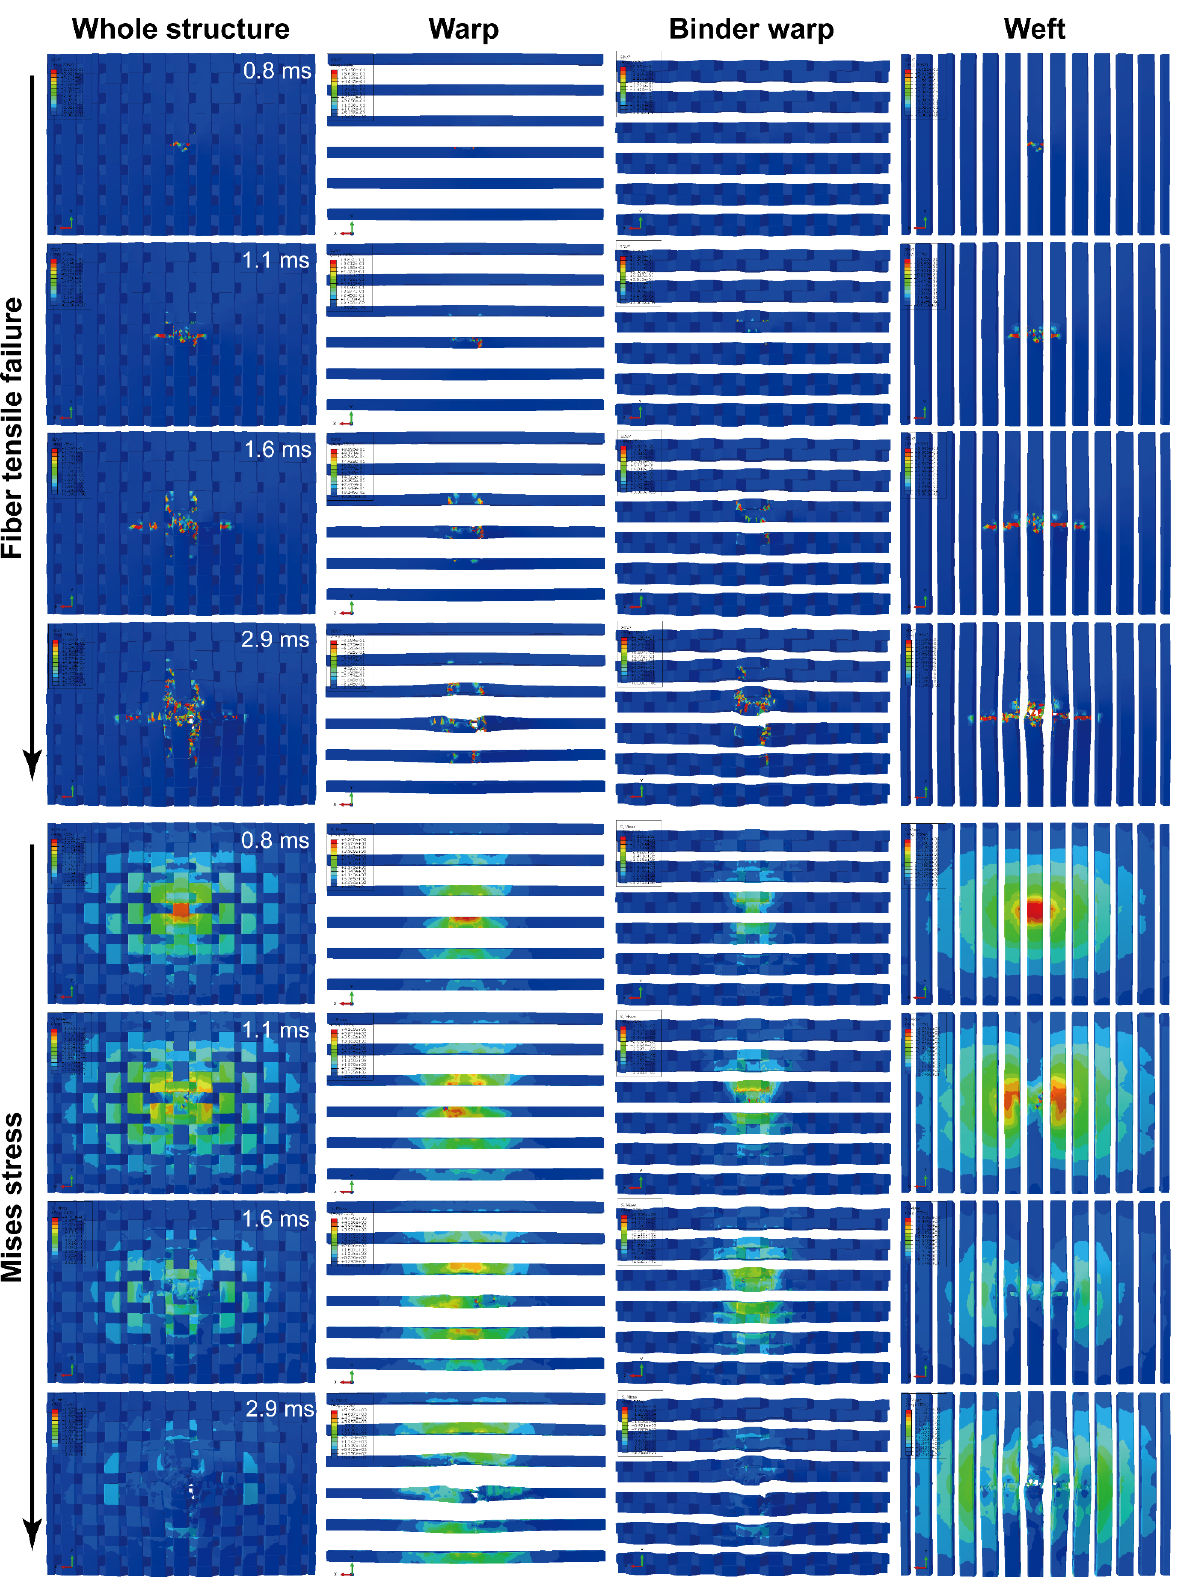
Figure 8. Damage evolutions and corresponding stress distributions of the whole structure and component yarns for a 90° specimen under 47.6 J of impact energy.